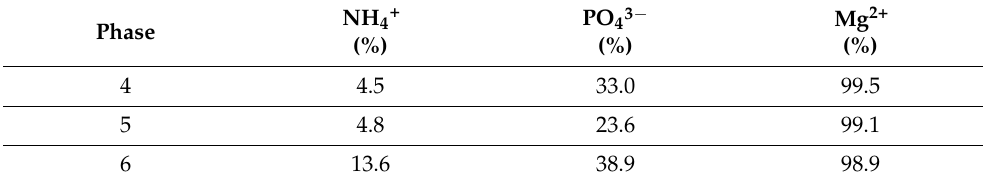
Table 4. Estimation of the fraction of precipitated components on the recovery solution in each phase when adjusting the pH to 8. Phase 4: catholyte acidified to pH 5 and phosphate amended; Phase 5: phosphate amended catholyte; Phase 6: phosphate amended